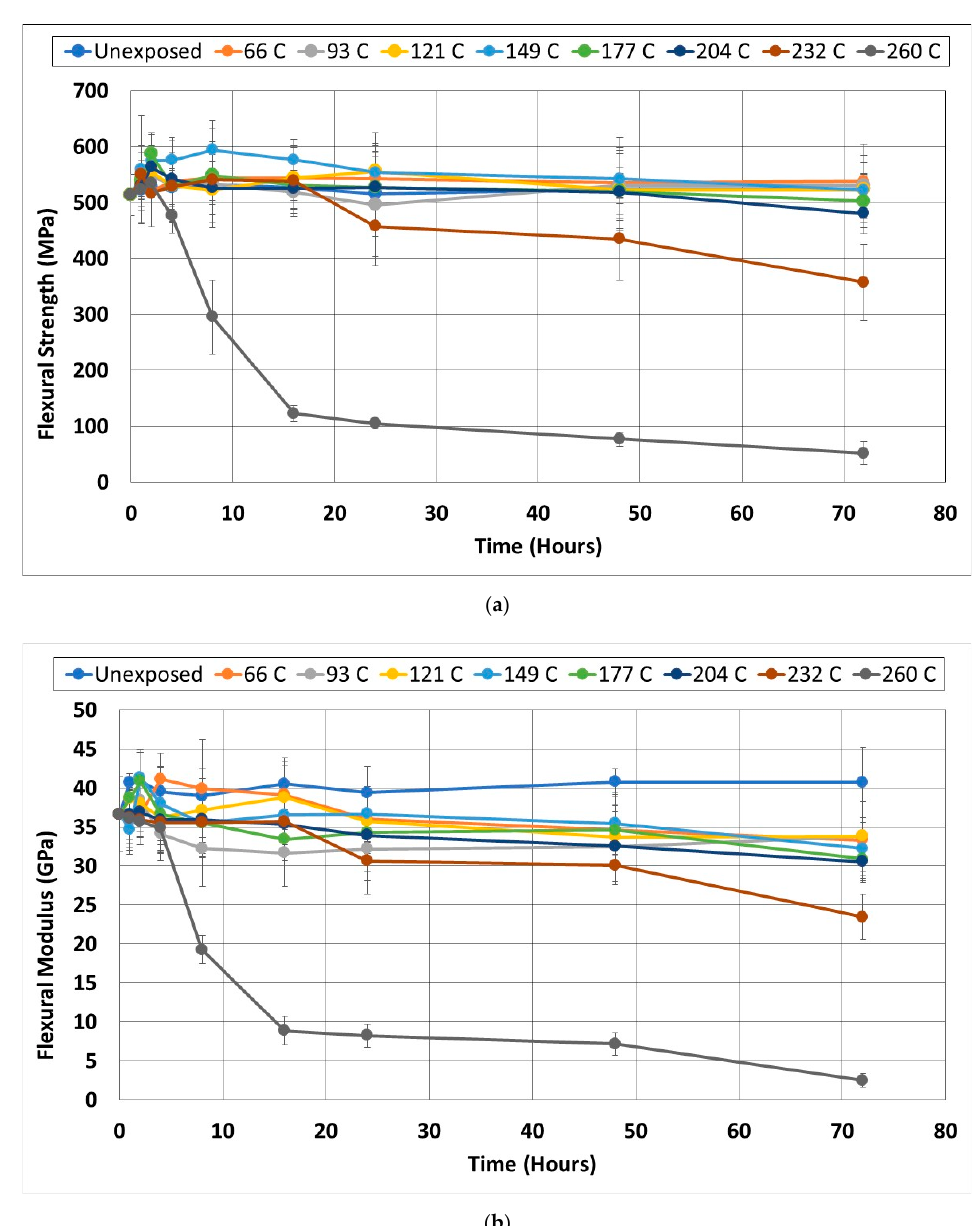
Figure 7. ( a ) Change in Flexural Strength as a function of exposure temperature and time; ( b ) Change in Flexural modulus as a function of exposure temperature and